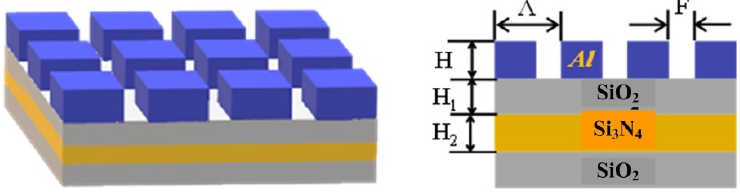
Figure 1. Structure diagram of the two-dimensional sub-wavelength grating. Table 1. Geometric structure and shape parameters. Parameters Range grating height, H